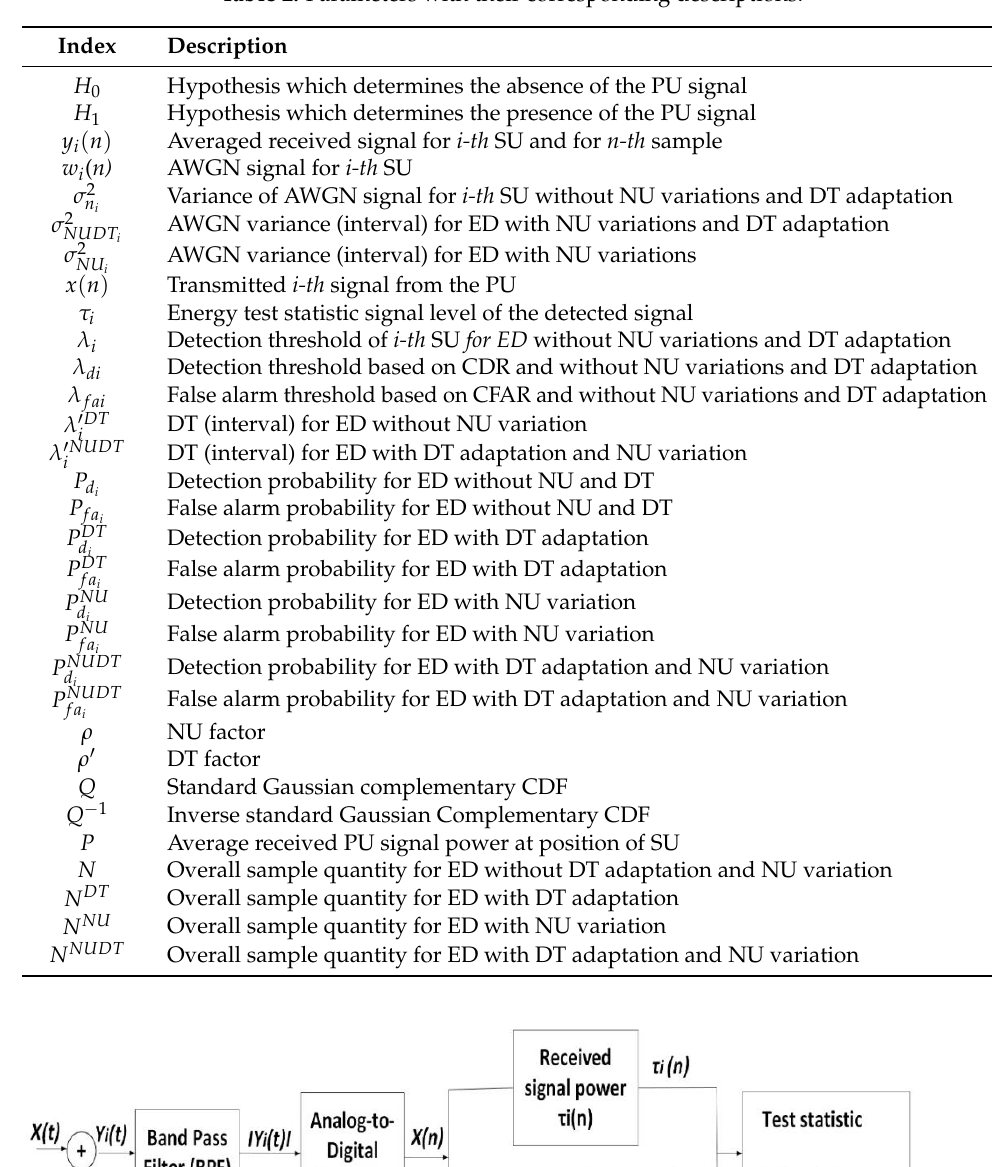
Table 2. Parameters with their corresponding descriptions.